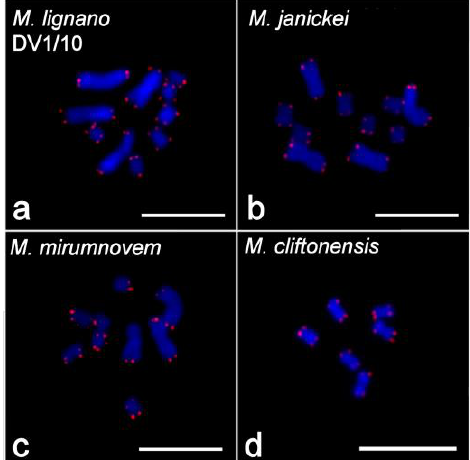
Figure 4. Two-color fluorescent in situ hybridization (FISH) with probes specific to 28S rDNA (green) and 5S rDNA (red) on chromosomes of four Macrostomum species: ( a ) inbred DV1/10 line of M. lignano and outbred cultures of ( b ) M. janickei , ( c ) M. mirumnovem, and ( d ) M. cliftonensis . Chromosomes were counter-stained with DAPI (blue). Scale bar 10 µm.